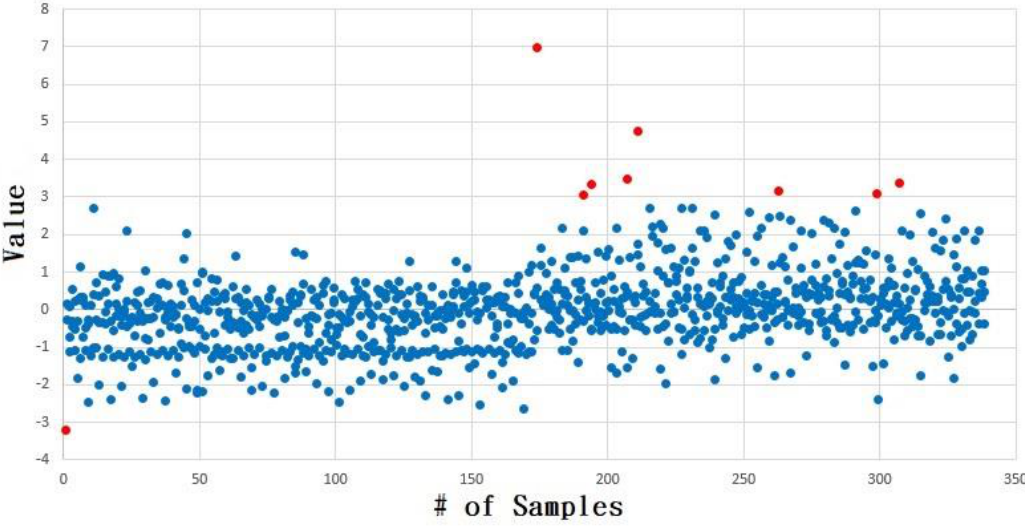
Figure 11. The Z-score technique for removing the outliers ( red ) among the acquisitioned data ( blue ).